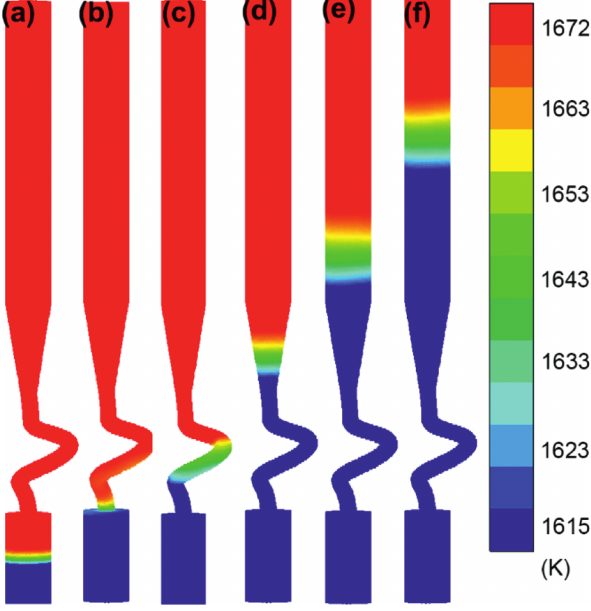
Figure 4: Mushy zone distribution of Ni-based samples for the LMC process: (a) t = 90 s, f s = 10%; (b) t = 132 s, f s = 20%; (c) t = 145 s, f s = 22 %; (d) t = 672 s, f s = 27%; (e) t = 965 s, f s = 45%; (f) t = 1,254 s, f s =